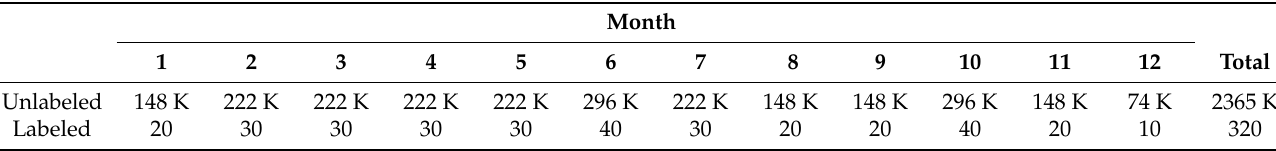
Table 1. The number of samples per month for labeled and unlabeled datasets.